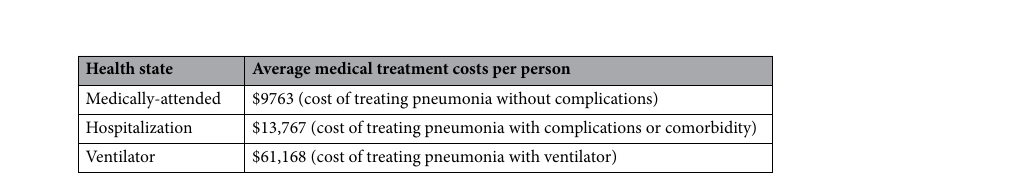
Table 3. Average cost of medical care under different health states 35